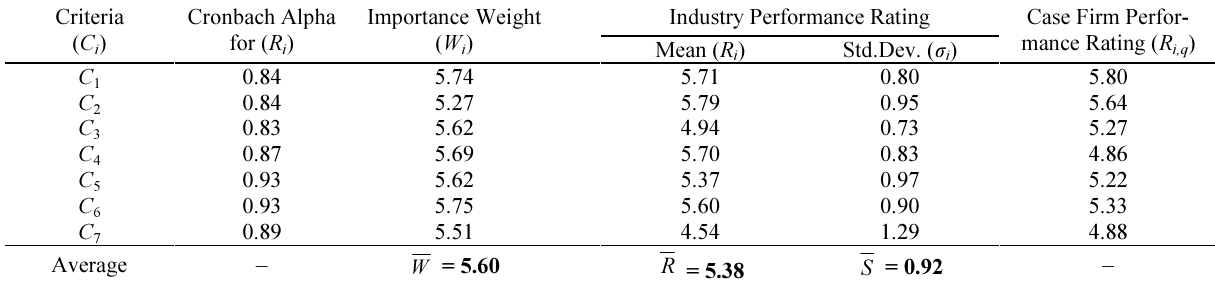
Table 3. Cronbach Alpha values, importance weights and performance ratings